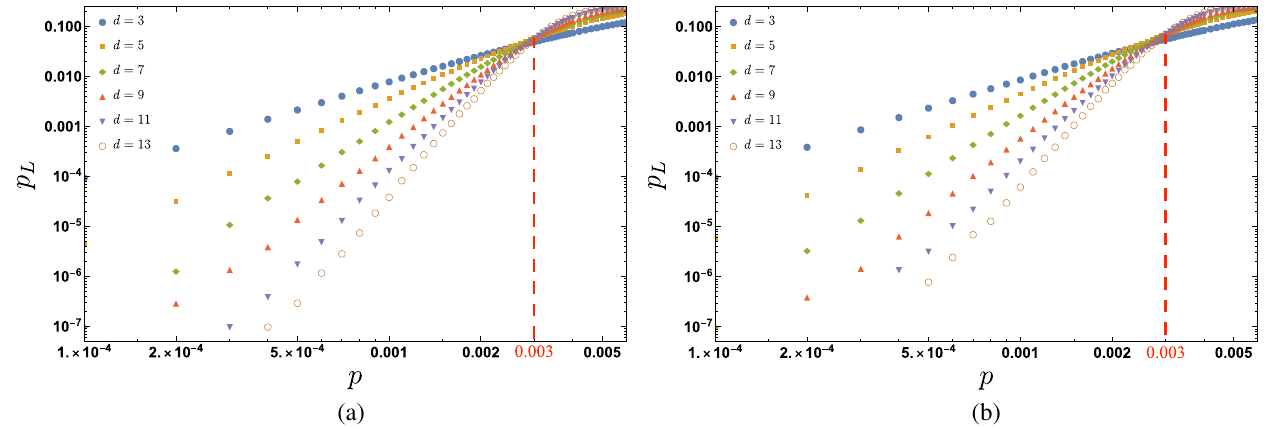
FIG. 17. (a) Logical X -error rates and (b) logical Z -error rates for the heavy-square code. The asymptotic threshold can be seen to be 0 . 003 . approximately p th ¼